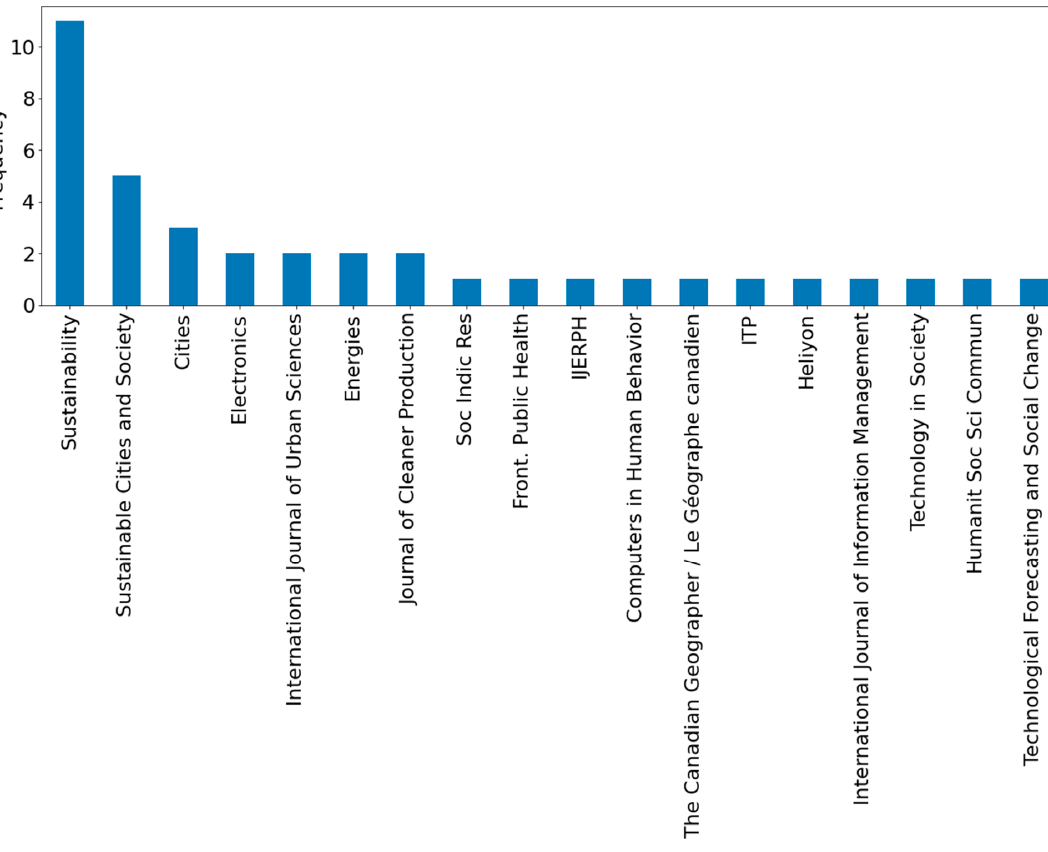
Figure 2. Journals in which the articles were published. Source: Authors’ own